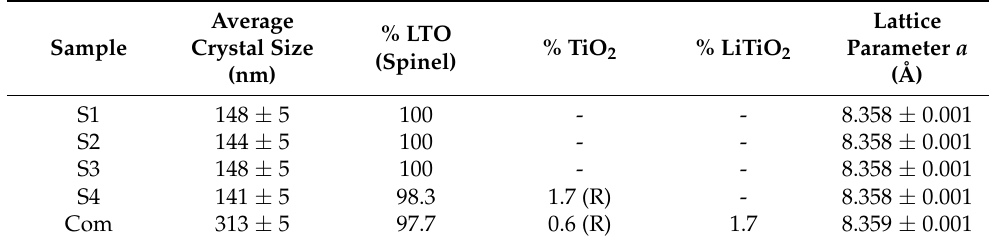
Table 1. Crystallite sizes and lattice parameters for pristine sol–gel and commercial LTO samples.